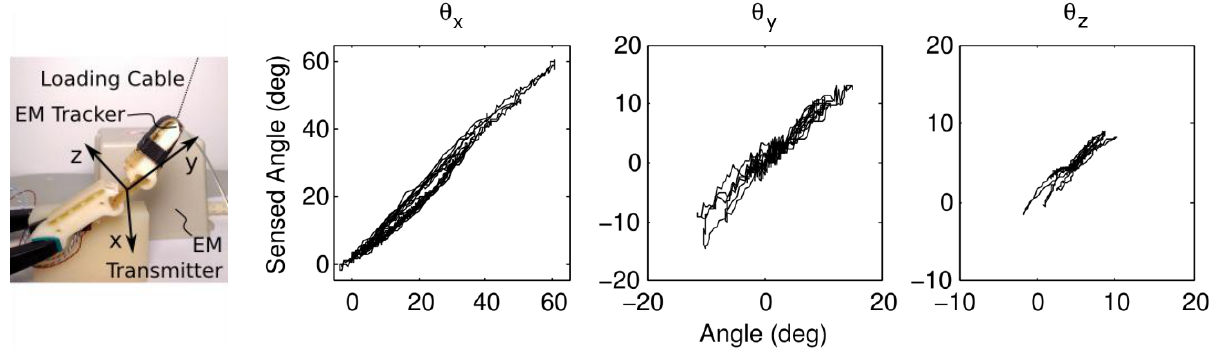
Figure 2. Sensor response: ( left ) experimental setup and ( right ) sensed angles across joint vs. actual angles measured with electromagnetic tracker.